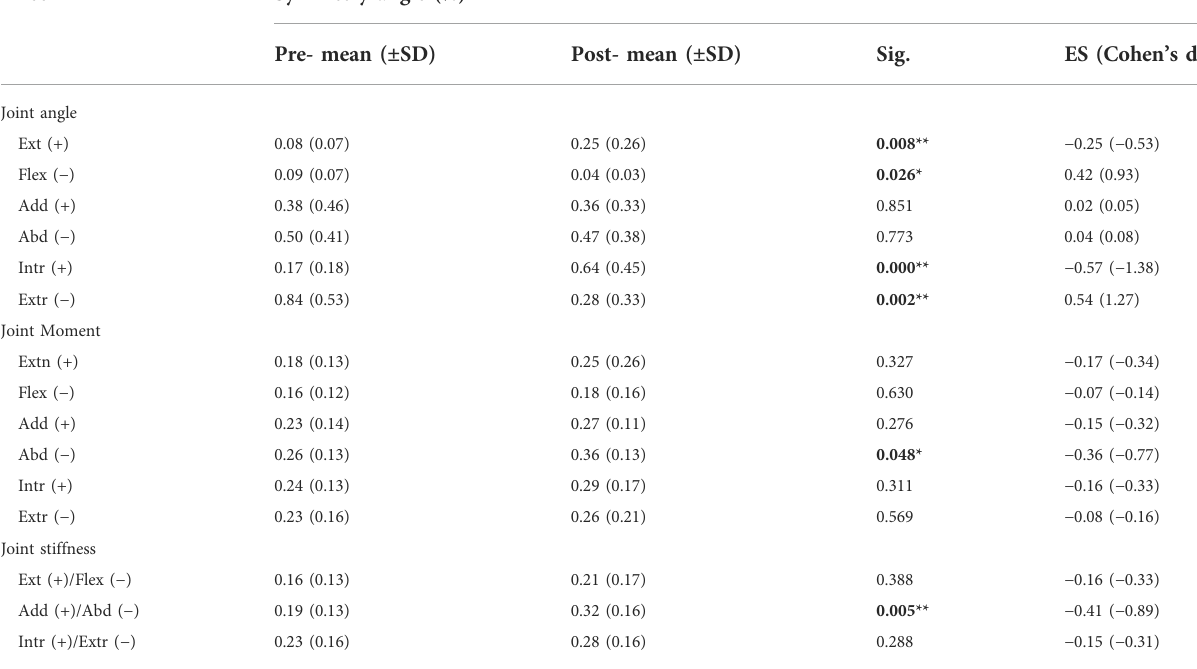
TABLE 3 Changes of knee joint angle, joint moment, range of motion and joint stiffness symmetry before and after